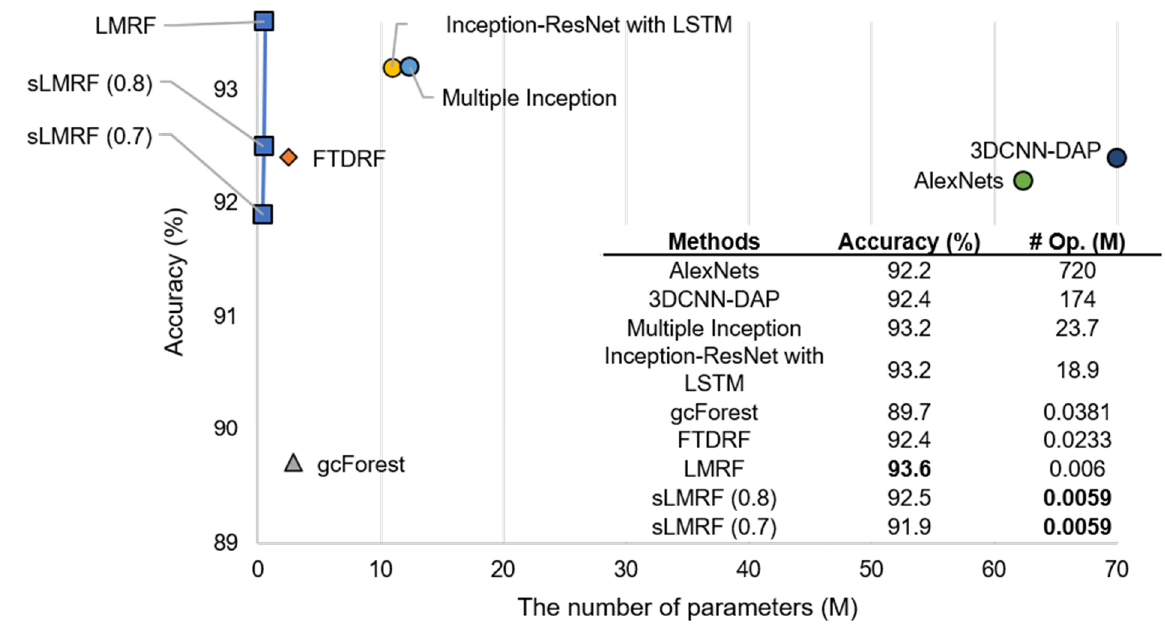
Figure 3. Comparison of accuracy, numbers of parameters (# Param.), and numbers of operations (#Op.) with the state-of- the-art methods using the CK+ dataset.